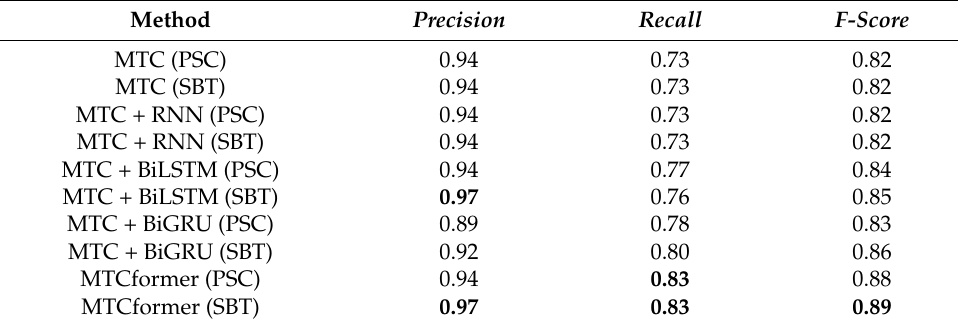
Table 3. The performance comparison when using the SBT sequence and plain source code as input.